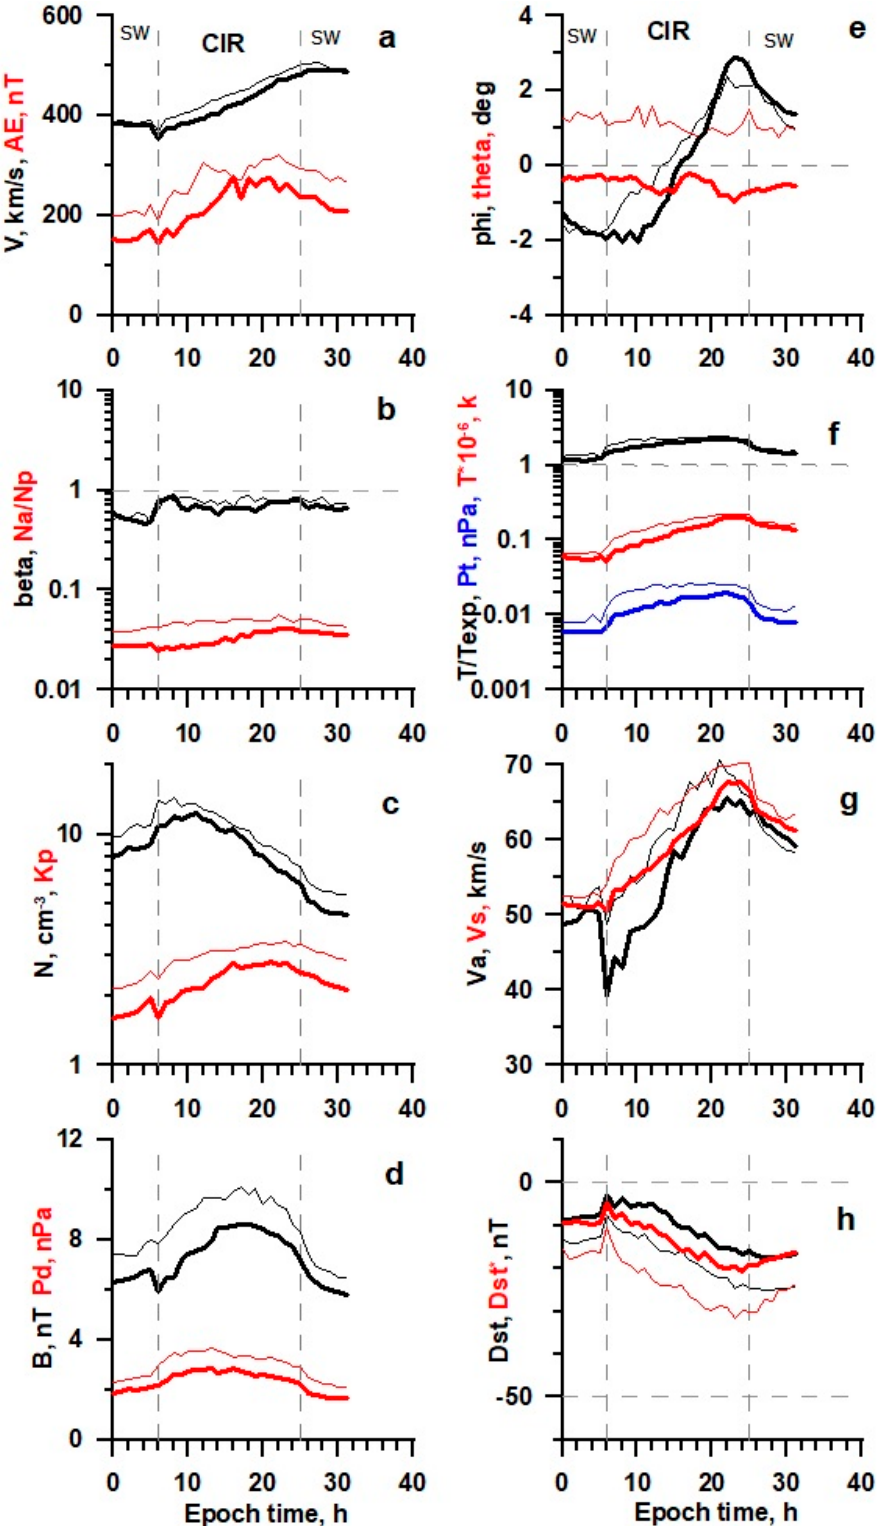
Figure 1. The temporal profile of solar wind and IMF parameters (see legend in the text) for CIR obtained by the double superposed epoch analysis for 224 events in 21–22 SCs (thin lines) and 253 events in 23–24 SCs (thick